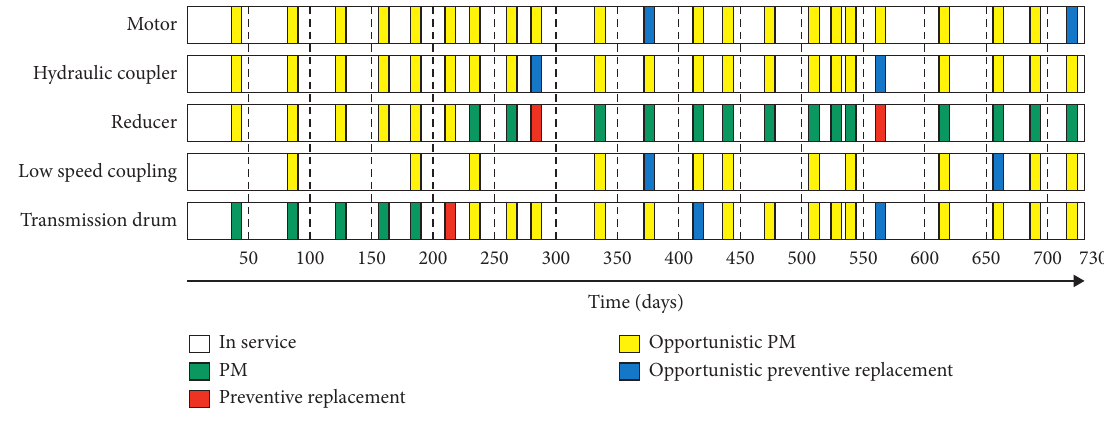
Figure 11: OM schedule of the belt conveyor drive